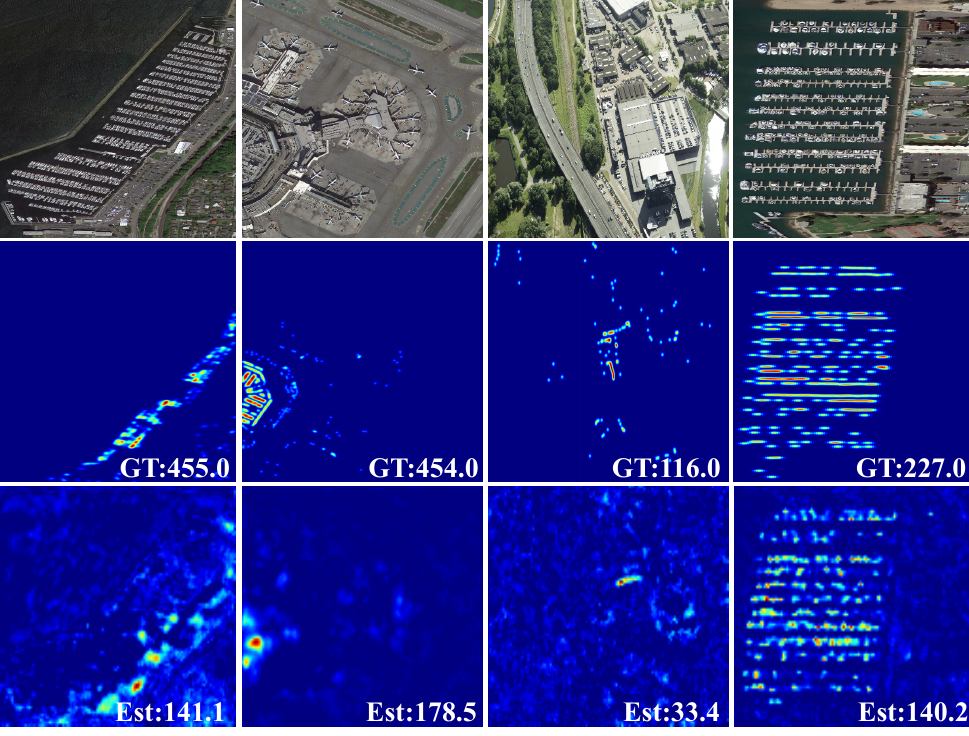
Figure 13. Failure cases on the RSOC